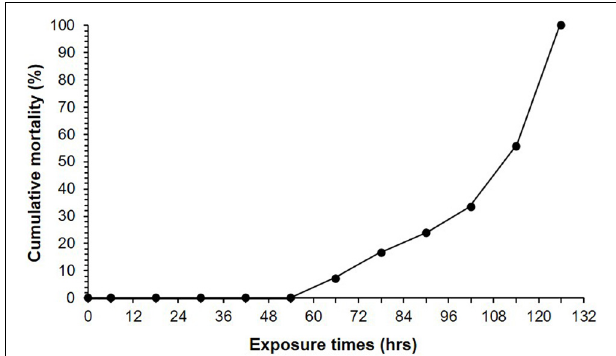
FIGURE 5 | Cumulative mortality of Mytilisepta virgata . Mortality was monitored after 6, 18, 30, 42, 54, 66, 78, 90, 102, 114, and 126 h under heatwave